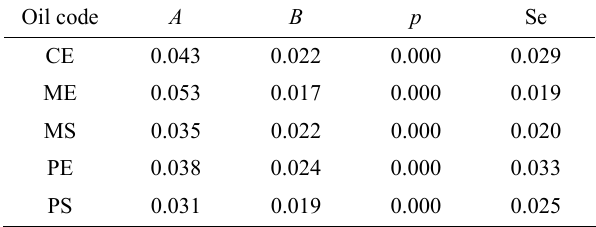
Table 4 The outcomes of the estimation of linear regression model for oxidation.